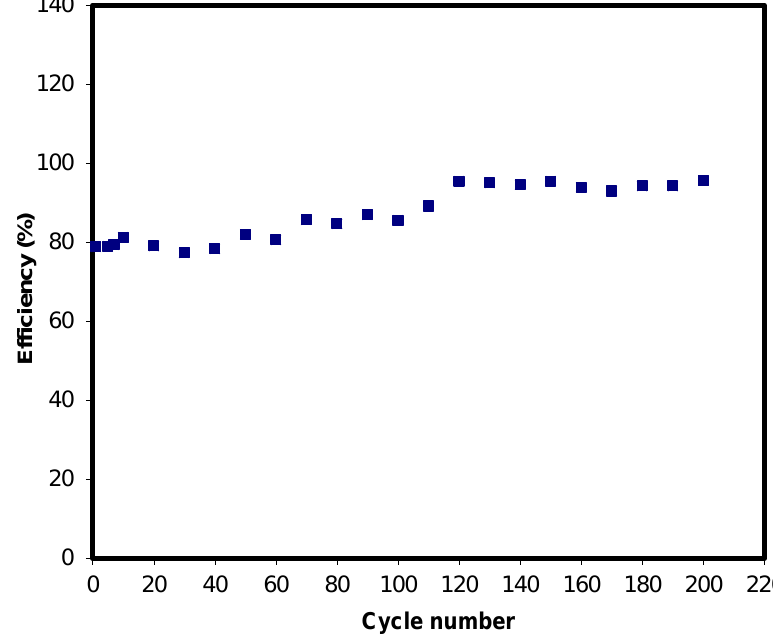
Figure 9. The plot of Coulombic efficiency ( 𝜂 ) of the fabricated EDLC for 200 cycles.